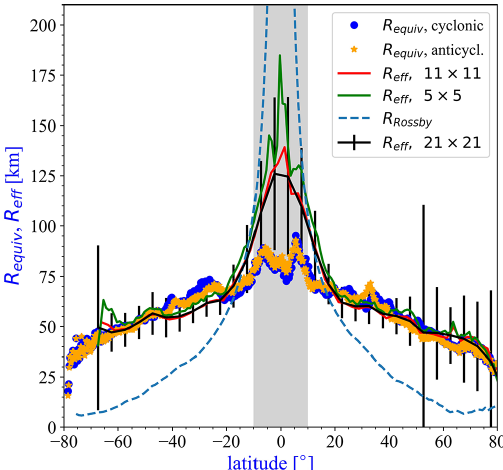
Figure 4. Zonal and temporal mean values of the characteristic vor- tex sizes R equiv and R eff for five datasets. Solid symbols are statis- tics from the vortex database (Faghmous et al., 2015), with 32 mil- lion cyclonic (blue symbols) and about the same number of anti- cyclonic eddies (orange stars) MEs. Solid lines are the estimates by Eq. (5) for the three tilings; see legend. The gray band denotes the equatorial region of low correlations (see Fig. 1) where the es- timates for R eff are particularly unreliable. Black error bars are for R eff statistics (1 σ ) with the largest tiles (21 × 21) of integration. For comparison, the dashed line indicates the zonal mean Rossby radius of deformation; data are from Chelton et al.